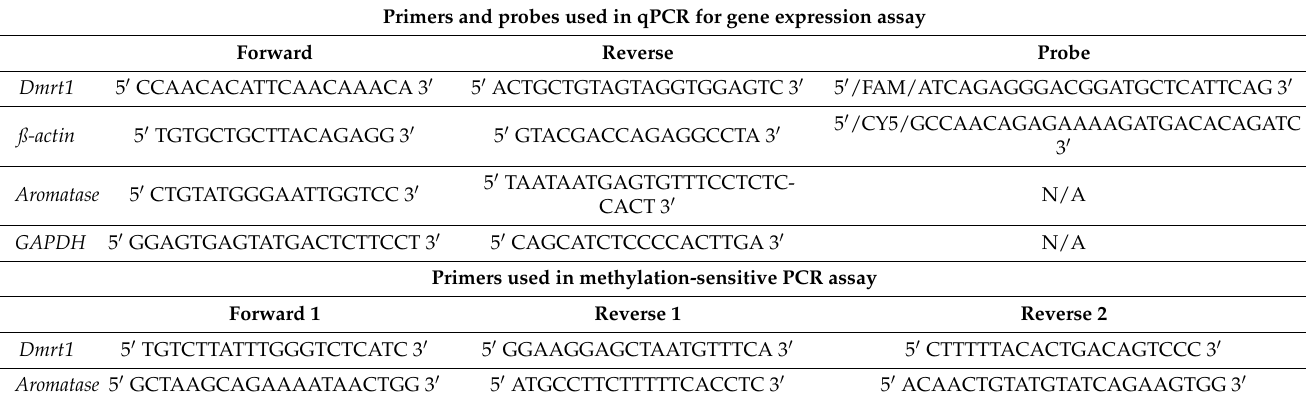
Table 1. Primers and probes used in this study (see text for